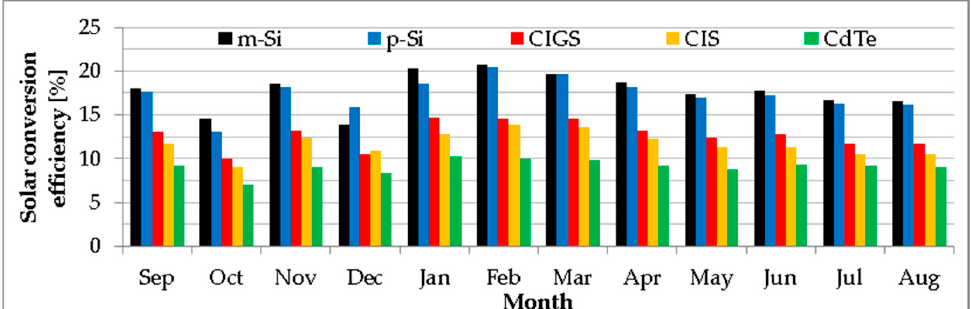
version efficiency is calculated for each of the five photovoltaic modules and compara- tively presented in Figure 22 for the fixed PV platform and in Figure 23 for the tracked PV platform.